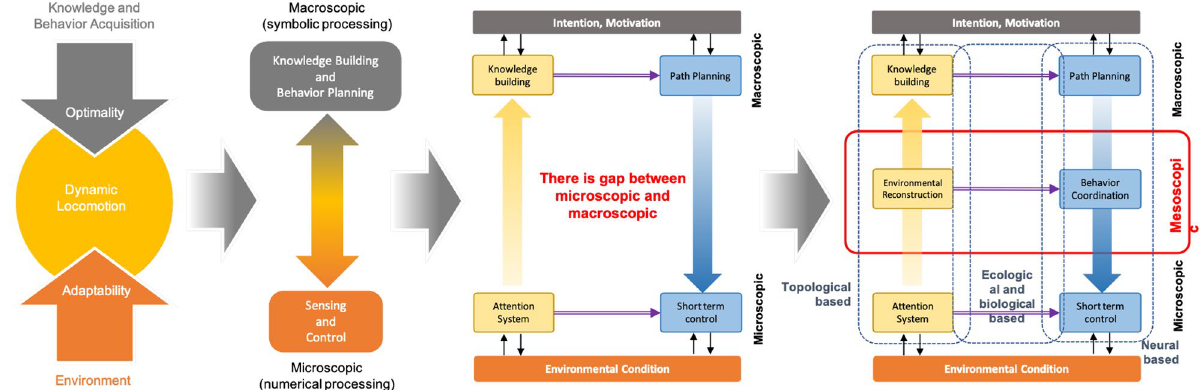
Figure 4. Concept of multi-scopic neuro-cognitive